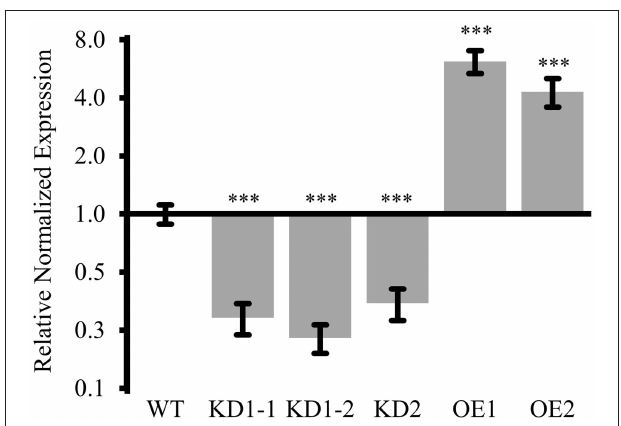
FIGURE 5 | COX11 mRNA levels in KD and OE lines. COX11 transcript levels were determined in KD and OE lines by qPCR. RNA was isolated from 14-day-old seedlings cultured on selective or non-selective MS plates. Mean values of mRNA levels in COX11 mutants were normalized to WT and plotted on logarithmic scale (base two). Values and statistical significance (compared with the WT, *** P < 0.001 ), were calculated with the CFX manager software. Error bars represent ± standard deviation (SD). Individual values are listed in the Supplementary Table 5.